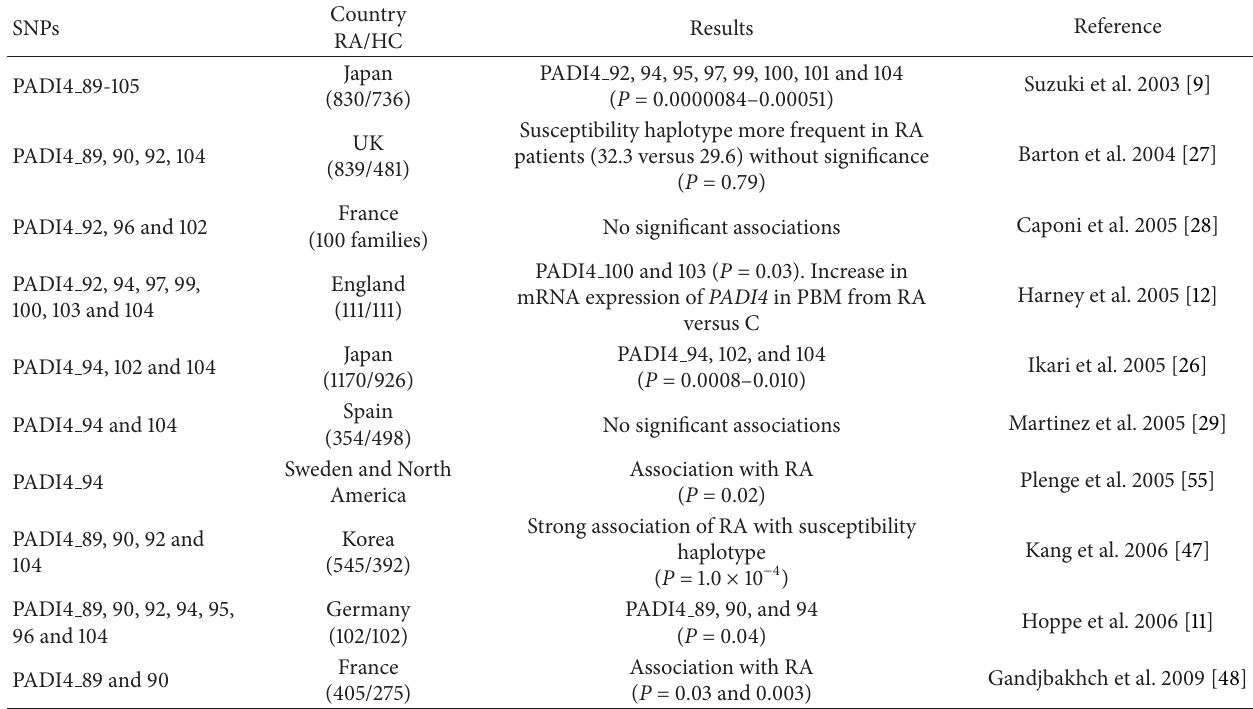
Table 5: Association studies for PADI4 SNPs and rheumatoid